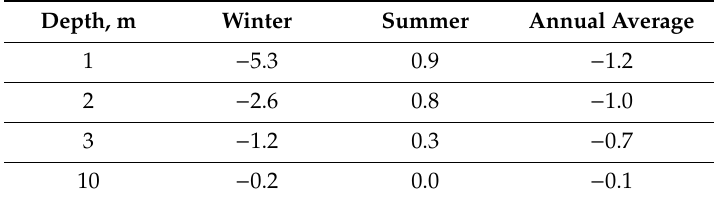
Table 2. Extreme and annual di ff erences between the natural ground temperature and the temperature in an air-dry borehole with a 50 mm diameter and metal casing, Yakutsk.